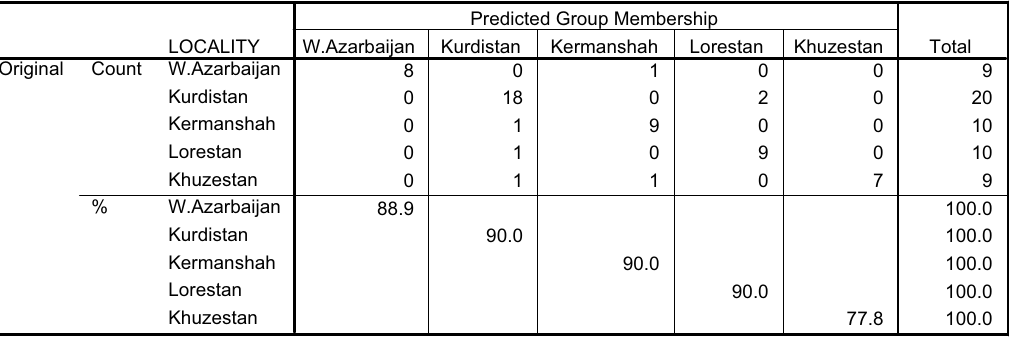
T ABLE 6. - Percentage of grouping membership in five populations of T. a.transcaucasica and T. septemtaeniata (=Khuzestan